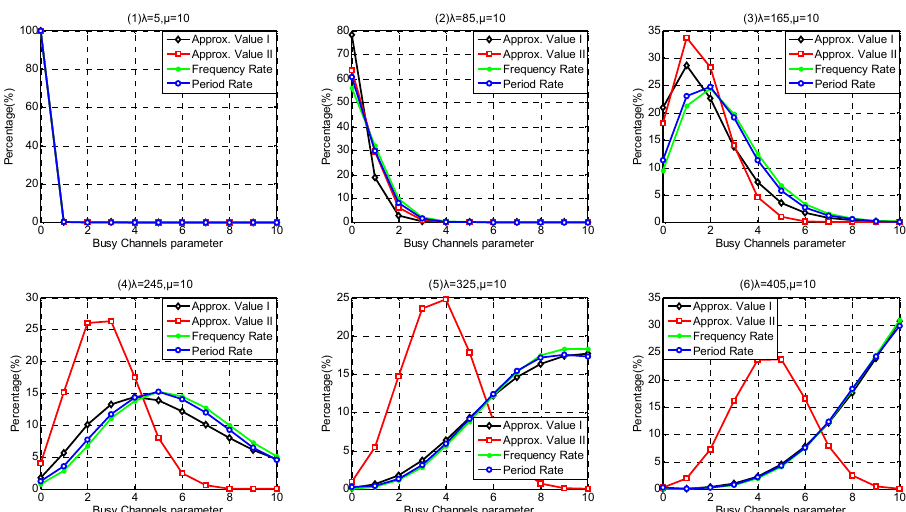
Figure 14. Busy-channel Parameter probability distribution under m -tolerated channel conflict model in Service-independent coexisting